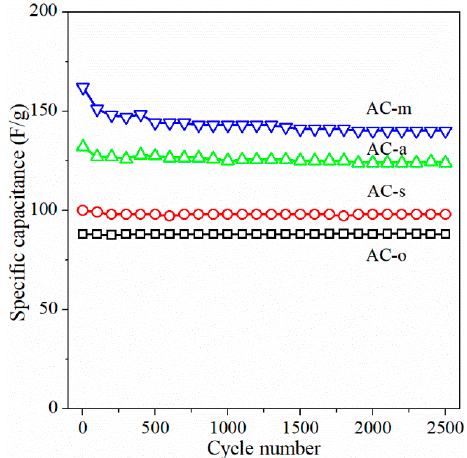
Figure 7. Cycling performance of the samples at a current density of 5 A/g.